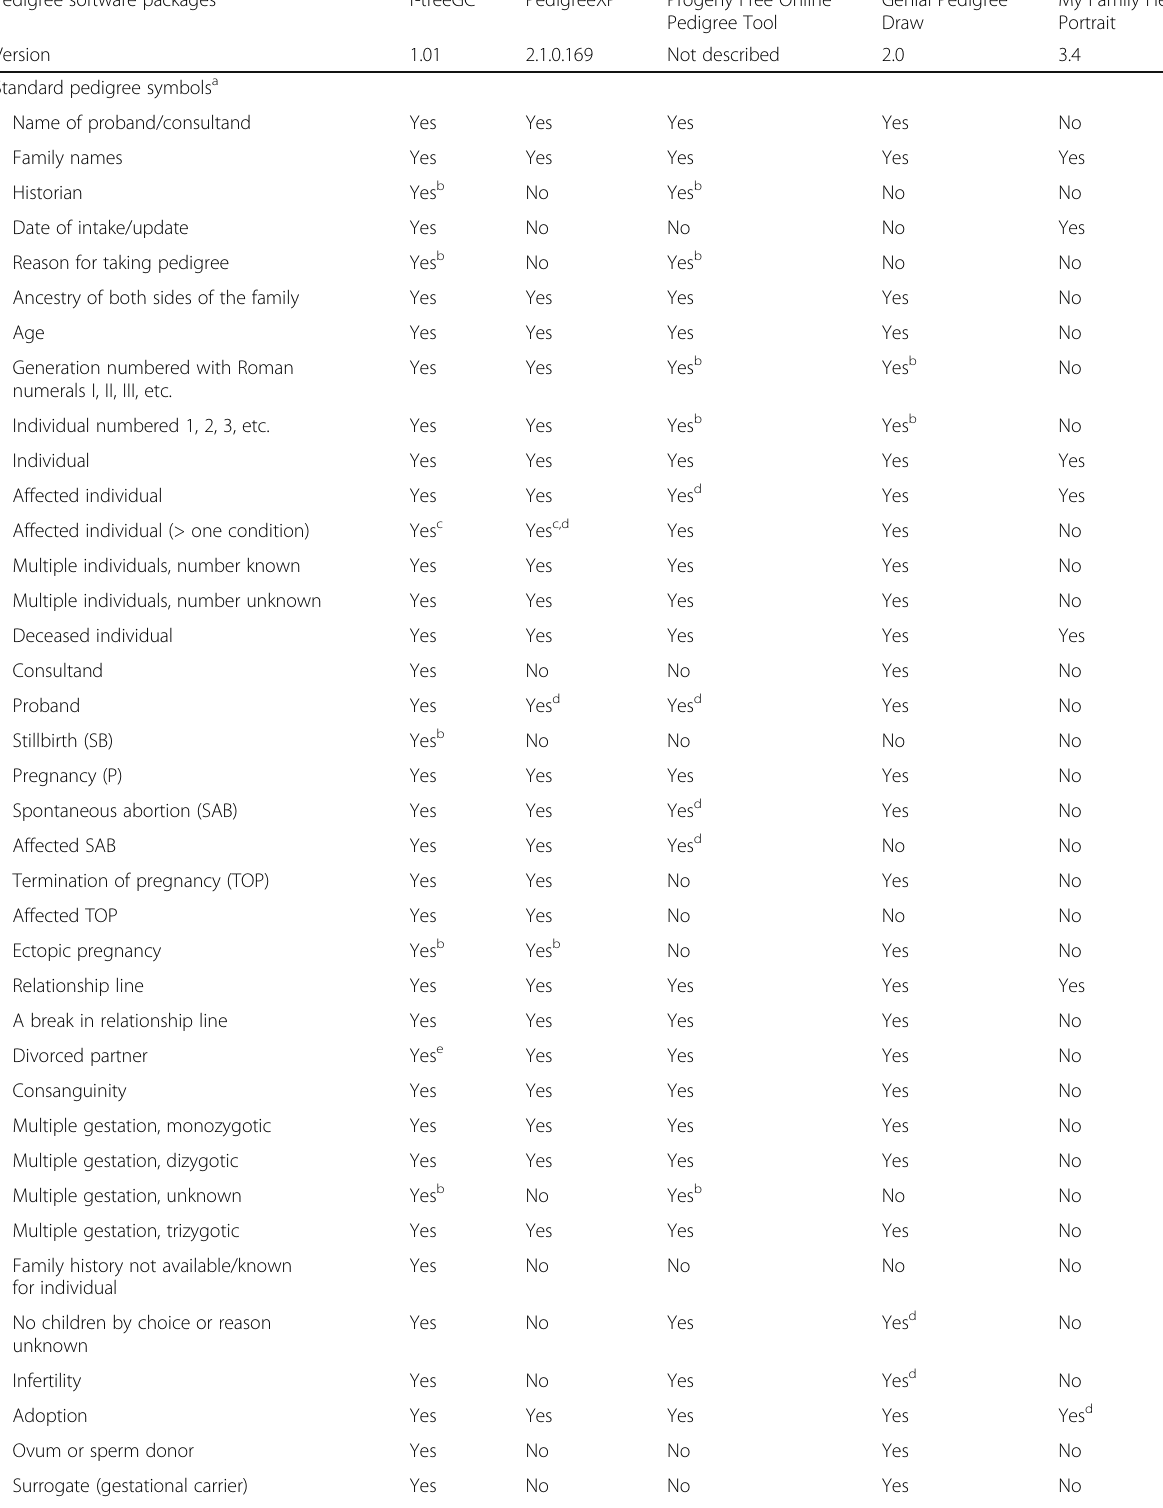
Table 2 Comparison of the pedigree symbols